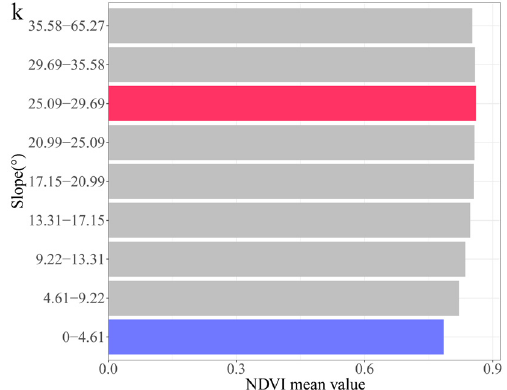
Figure 13. The statistical outcomes of NDVI at different levels for different environmental factors ( a – k ). Note: “needleleaf”—“needleleaf forest”, “alpine”—“alpine vegetation”, “cultural”—“cul- tural vegetation”, “Mix B-C”—“mixed broadleaf-conifer mixed forest”, “Broadleaf”—“broadleaf forest”.